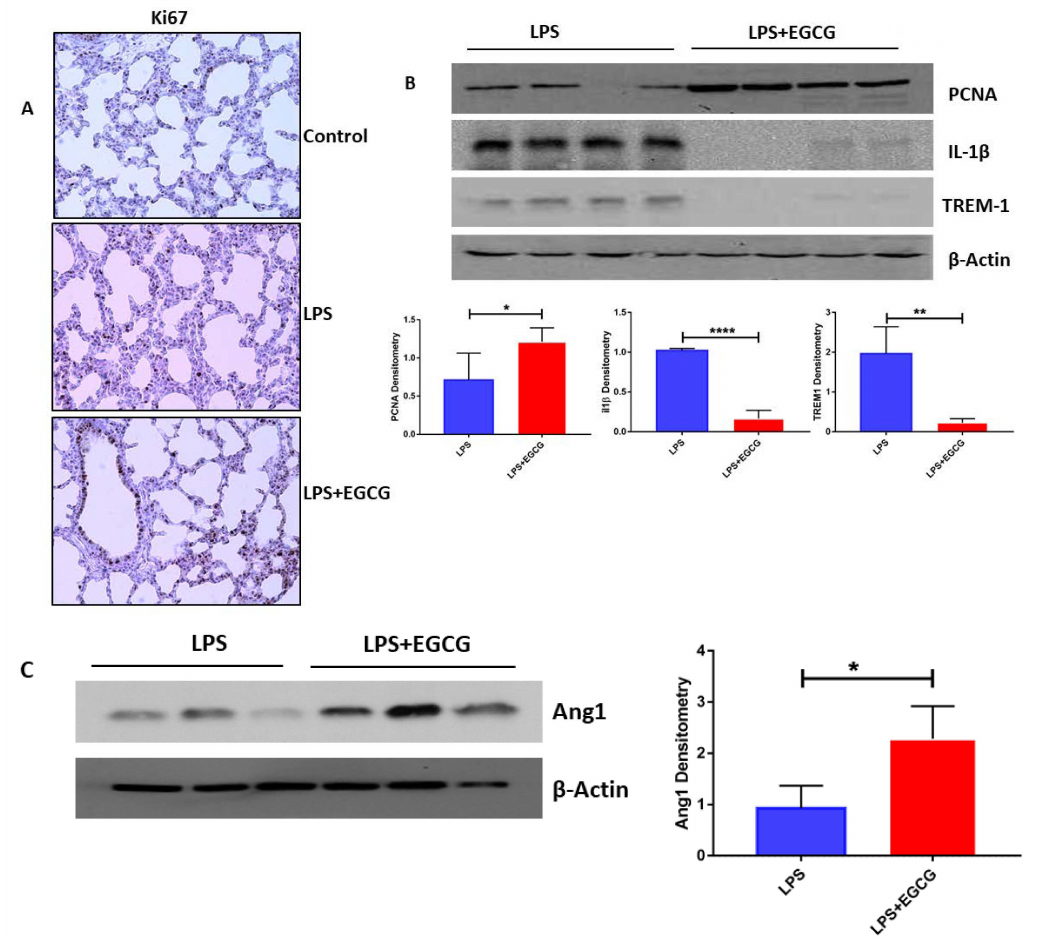
Figure 7. EGCG improves cell proliferation and inhibits other inflammatory mediators. ( A ) The lung Ki67 protein expression shown by immunohistochemistry in the di ff erent study groups (10 × objective) showed diminished expr of Ki67 in LPS-instilled group, EGCG treatment improved Ki67 staining. ( B ) Western blot of di ff erent lung injury groups was performed to evaluate PCNA, TREM1 and IL-1b protein expression ( C ) Immunoblots of Ang1 performed in di ff erent lung injury groups. Actin was used in parallel as internal control. Significant di ff erence * p < 0.05, ** p < 0.01 and **** p <